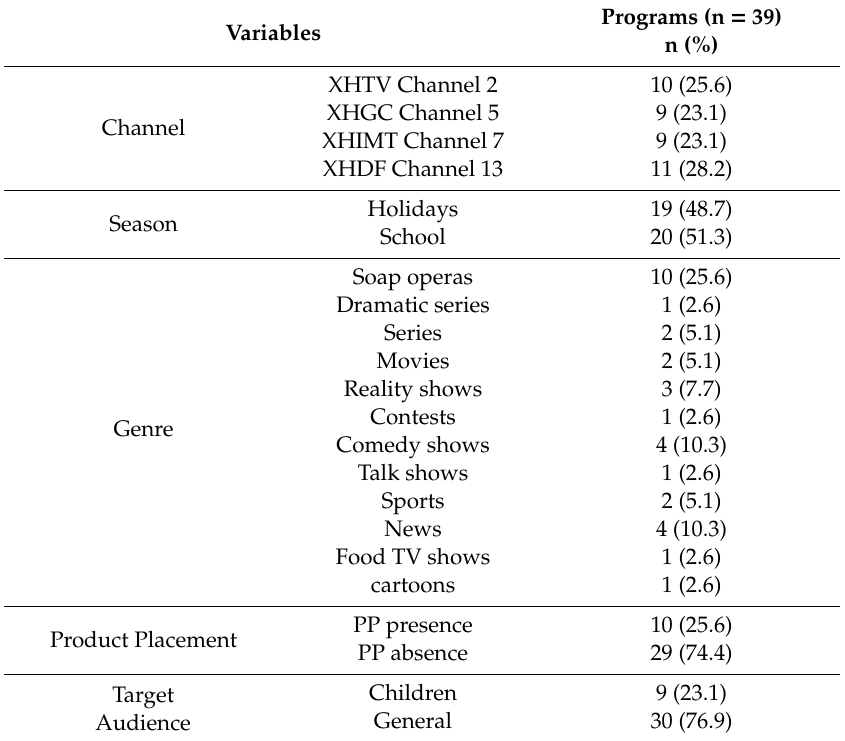
Table 2. Characteristics of the analyzed Mexican public television programs, broadcast from 19 to 22 h.